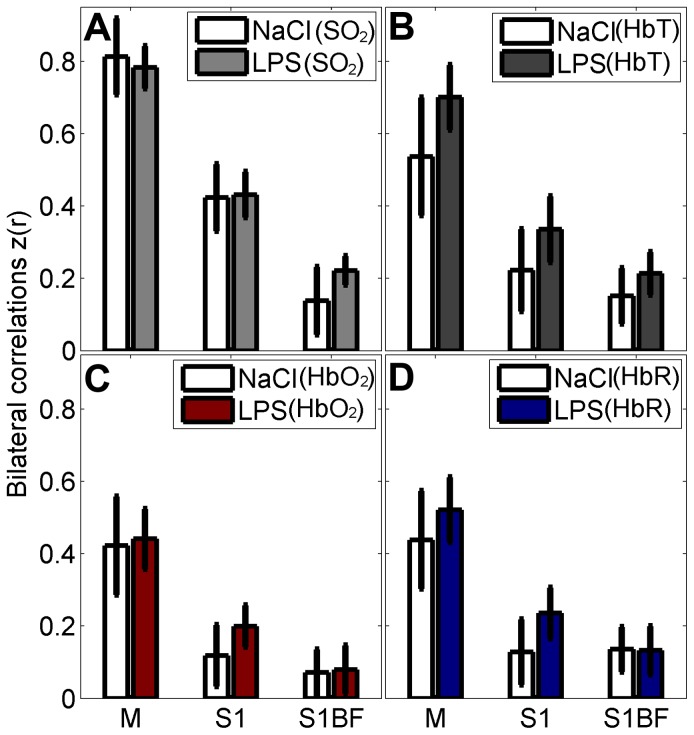
Regional bilateral functional correlation.Comparison performed between LPS group (N = 11), and NaCl (sham) group (N = 8); analysis done for every seed time-trace and its contralateral part. Contrasts shown: (A) SO2, (B) HbT (C) HbO2 and (D) HbR. Abbreviations: (M, motor cortex; S1, primary somatosensory cortex; S1BF, barrel field primary somatosensory cortex).